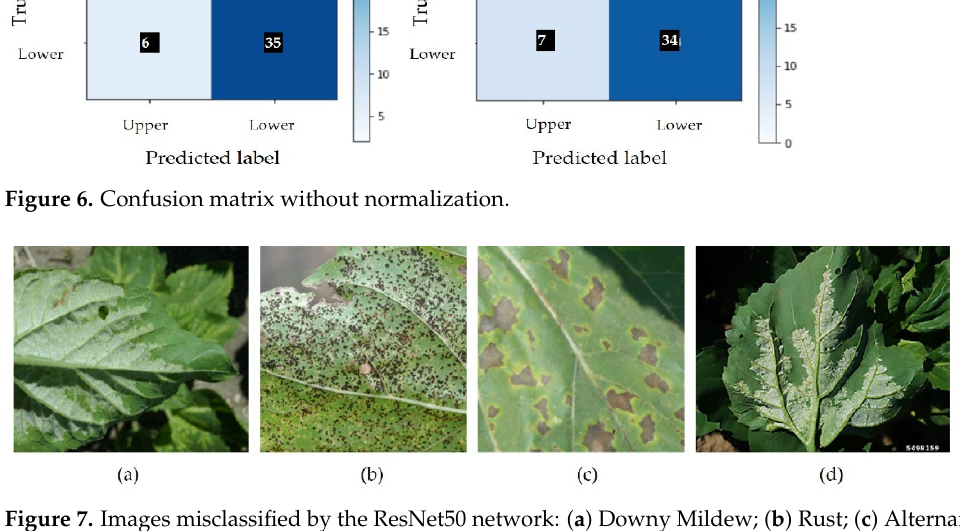
Figure 7. Images misclassified by the ResNet50 network: ( a ) Downy Mildew; ( b ) Rust; ( c ) Alternaria; ( d ) Downy Mildew